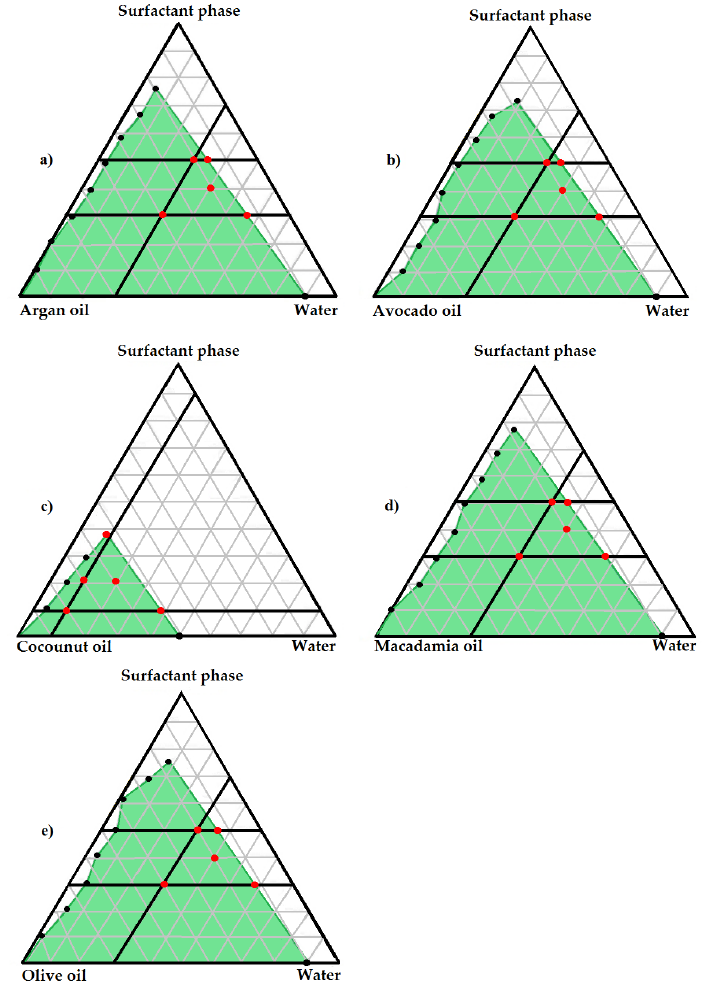
Figure 1. Phase diagram indicating check-point formulations for ( a ) argan oil, clofazimine, surfactant phase and water; ( b ) avocado oil, clofazimine, surfactant phase and water; ( c ) coconut oil, clofazimine, surfactant phase and water; ( d ) macadamia oil, clofazimine, surfactant phase and water; ( e ) olive oil, clofazimine, surfactant phase and water.